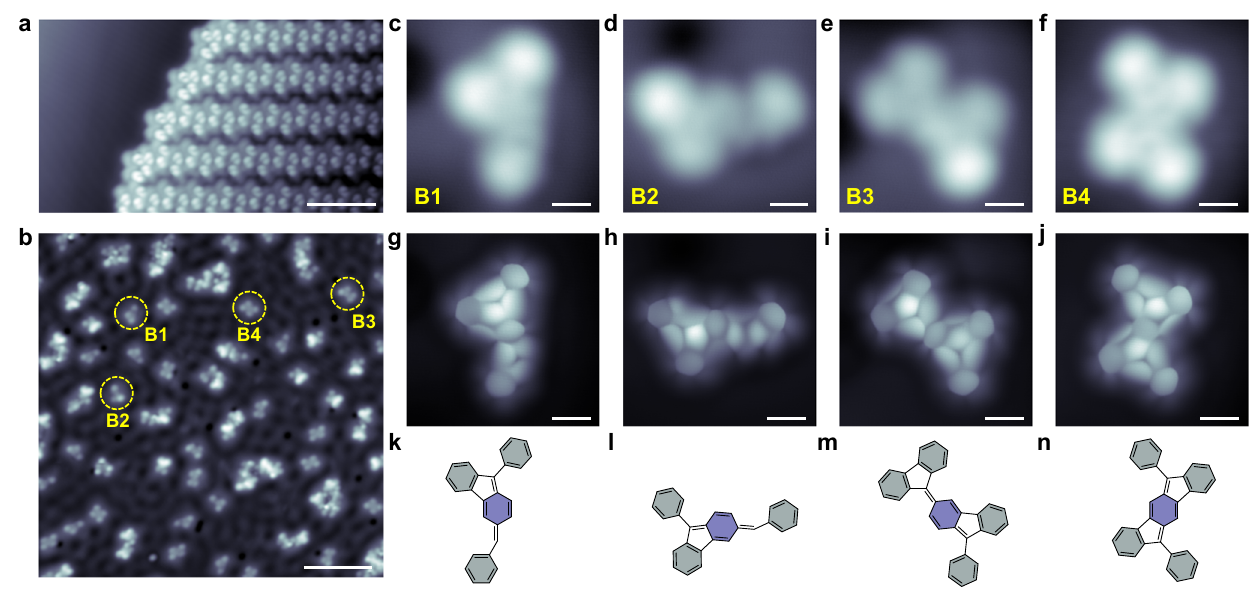
Fig. 4 | Products of phenyl migration reaction formed on Cu(111) after annealing at 420K. a STM topography of DMTPB self-assembly on Cu(111). b Large-scale STM topography ( I =50 pA, V s =100mV) of different products after thermal annealing of the DMTPB self-assembly on Cu(111) at 420K. c – f STM topographies (CO tip, I =50 pA, V s =100mV) of major monomer products, as denotedby yellowdashed circlesnumbered by B1 , B2 , B3 and B4 in a . g – j BR-STM